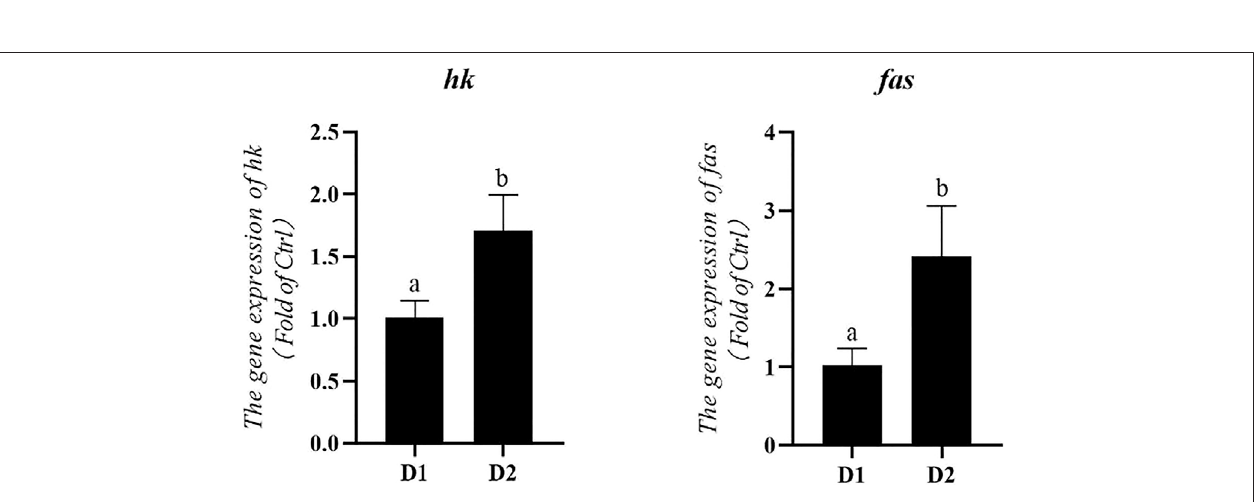
Frontiers in Physiology |